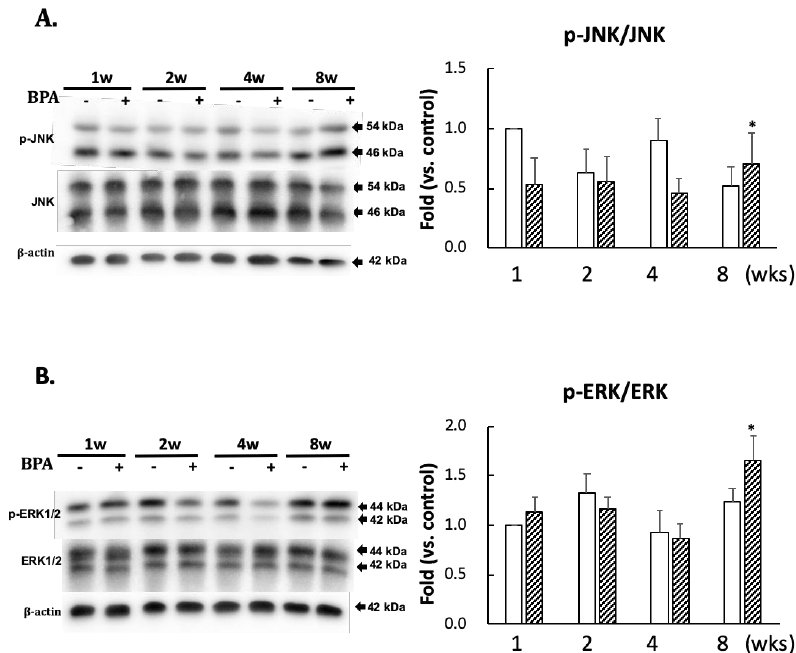
Figure 4. Effect of BPA treatment on phosphorylated JNK/total JNK and ( A ); and phosphorylated ERK/total ERK and ( B ). Open column, control and gray column, BPA. Values represent mean ± SD ( n = 3 to 6), * p < 0.05 vs. each control group.